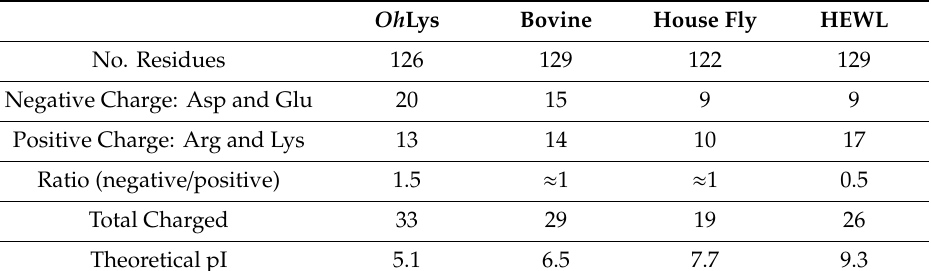
Table 3. The number of charged residues and pI for four representative lysozymes. Histidines have been excluded from the positive set.